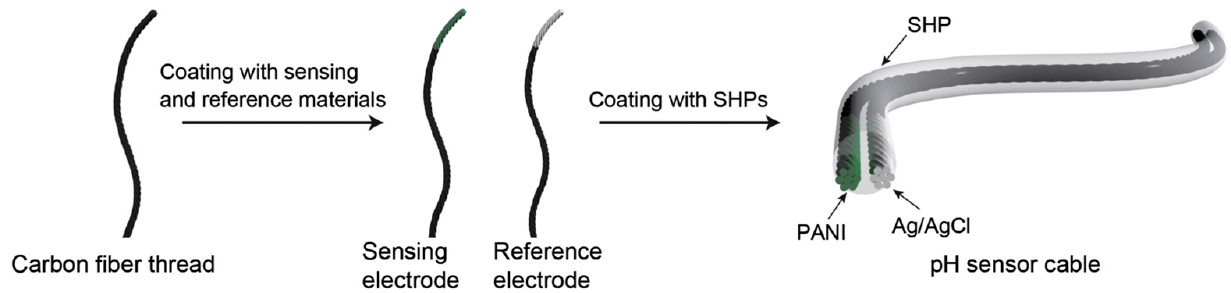
Figure 6. Schematic representation of a pH sensor cable based on a PANI pH sensing electrode and Ag/AgCl reference electrode, coated with a self-healing polymer. Adapted with permission from Ref. [162]. Copyright © 2019 Elsevier.